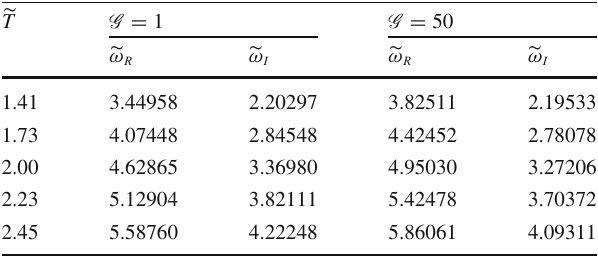
Table 5 Numerical results of the first quasinormal mode for (cid:10) q = 1 and high